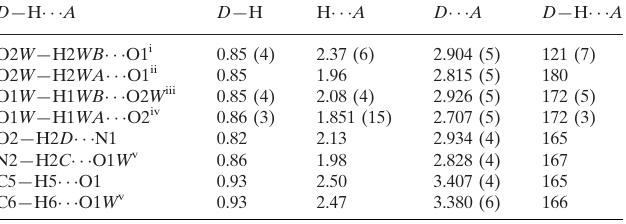
Hydrogen-bond geometry (A˚ , (cid:3) ). D —H (cid:2)(cid:2)(cid:2)